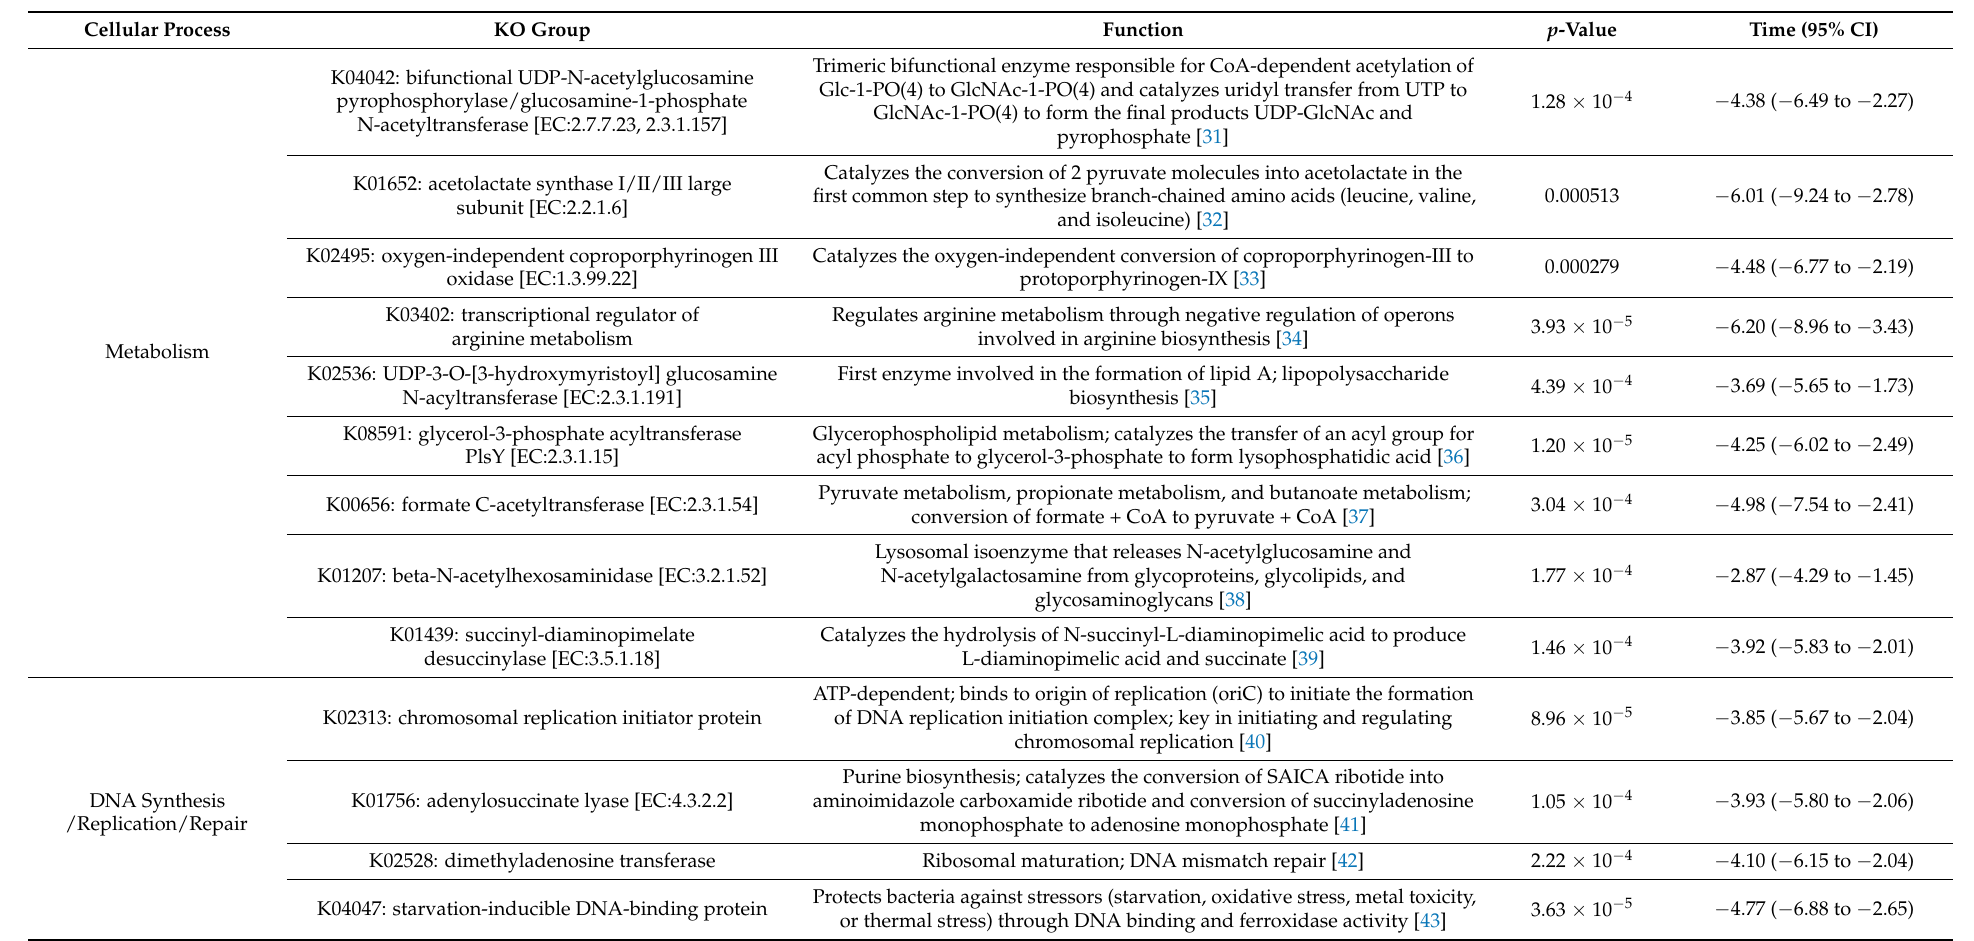
Table 2. KO Groups that decreased